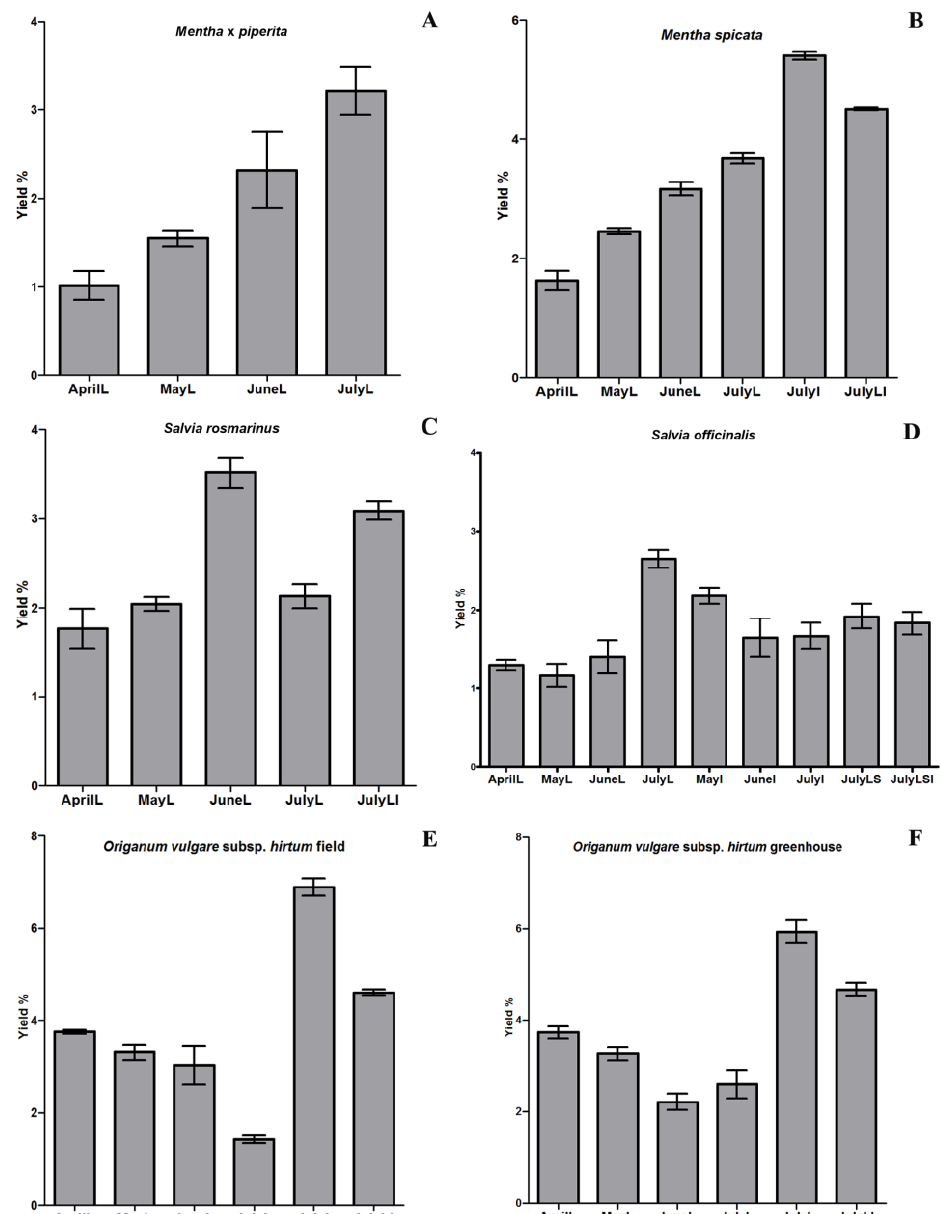
Figure 1. Essential oils’ yield of the studied plant species, collected monthly from April through July, using Kruskal–Wallis multiple comparison tests (L: leaves, I: inflorescences, LI: leaves and inflorescences, LS: leaves and stems, LSI: leaves, stems and inflorescences, added after the name of the collection month). ( A ) M. × piperita from fresh leaves ( p = 0.016), ( B ) M. spicata from fresh leaves and/or inflorescences, ( p = 0.005), ( C ) S. rosmarinus from fresh leaves and inflorescences ( p = 0.013), ( D ) S. officinalis from fresh leaves, inflorescences and stems ( p = 0.003), ( E ) O. vulgare subsp. hirtum from fresh leaves and/or inflorescences collected from the field ( p = 0.006) and ( F ) O. vulgare subsp. hirtum from fresh leaves and/or inflorescences collected from the greenhouse ( p = 0.006). M. spicata showed a significantly higher ( p < 0.05) EO content in the month of July when the plants were in full bloom and inflorescences were analyzed (5.40% ± 0.07), than that in the month of April (1.63% ± 0.16), when the plants have reached the end of